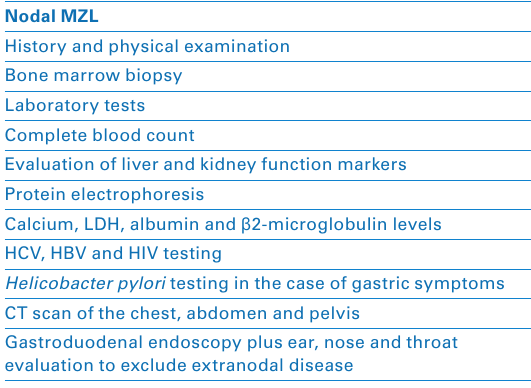
Table 3: Summary of work-up procedures for nodal marginal zone B-cell lymphoma (MZL) [57]. Nodal